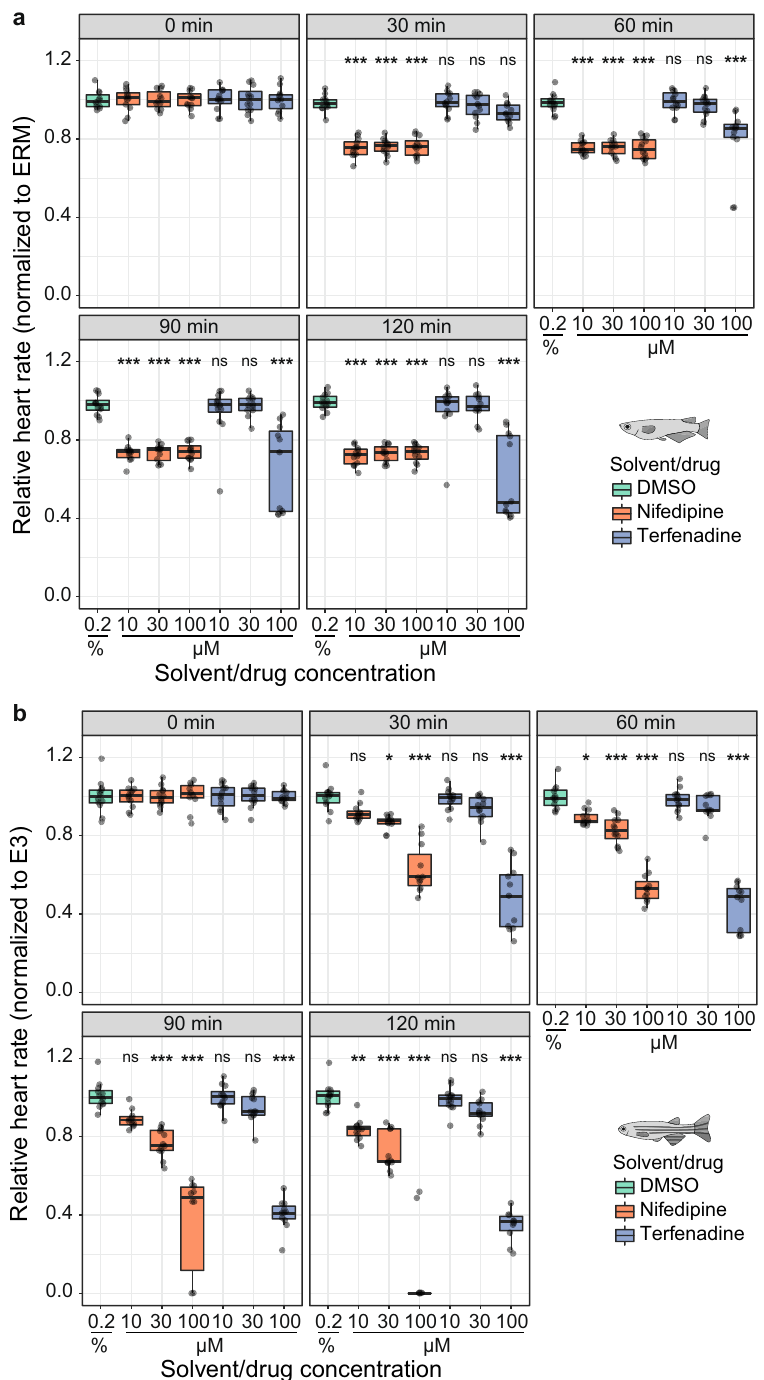
Figure 7. Heart rate inhibition by nifedipine and terfenadine over time. ( a ) Time course of drug effects revealing heart rate inhibition in medaka embryos (102–104 hpf) by nifedipine and 100 µ M terfenadine ( n = 11–12 each for DMSO, terfenadine 10/30/100 µ M, nifedipine 10/30/100 µ M at every time point). ( b ) Concentration-dependent heart rate decrease by nifedipine and terfenadine in zebrafish (32–34 hpf; n = 10–12 for all treatment and control groups at every time point). Significant difference between each drug concentration and the time-matched DMSO control group were tested with one-way ANOVA and pairwise comparisons using Student’s t -test and are given with * P < 0.05, ** P < 0.01 and *** P < 0.001, ns (not significant); data is visualized as box plots (median ± interquartile range) and scatter plots of original data points. At all points in time, each heart rate measurement of one of the treatment groups is normalized to the mean heart rate of a control group in fish medium (ERM/medaka, E3/zebrafish; data not shown) to account for stage-dependent changes and is expressed relative to the corresponding baseline treatment group mean (time point